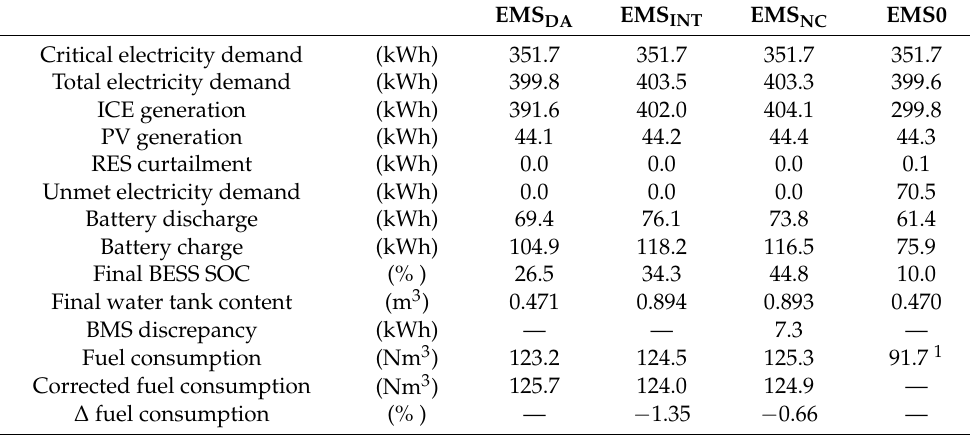
Table 5. Energy summary—day 3 (the microgrid was operated with EMS NC , while the others are simulations results).